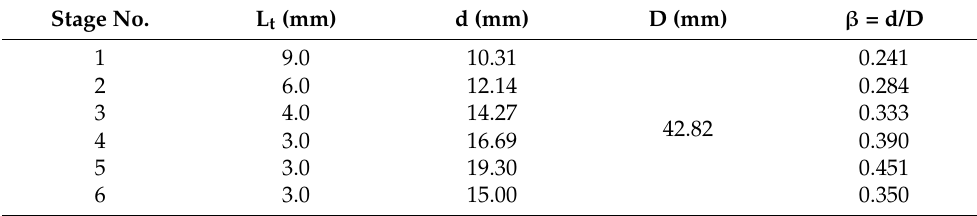
Table 1. The geometrical information for six-stage orifice